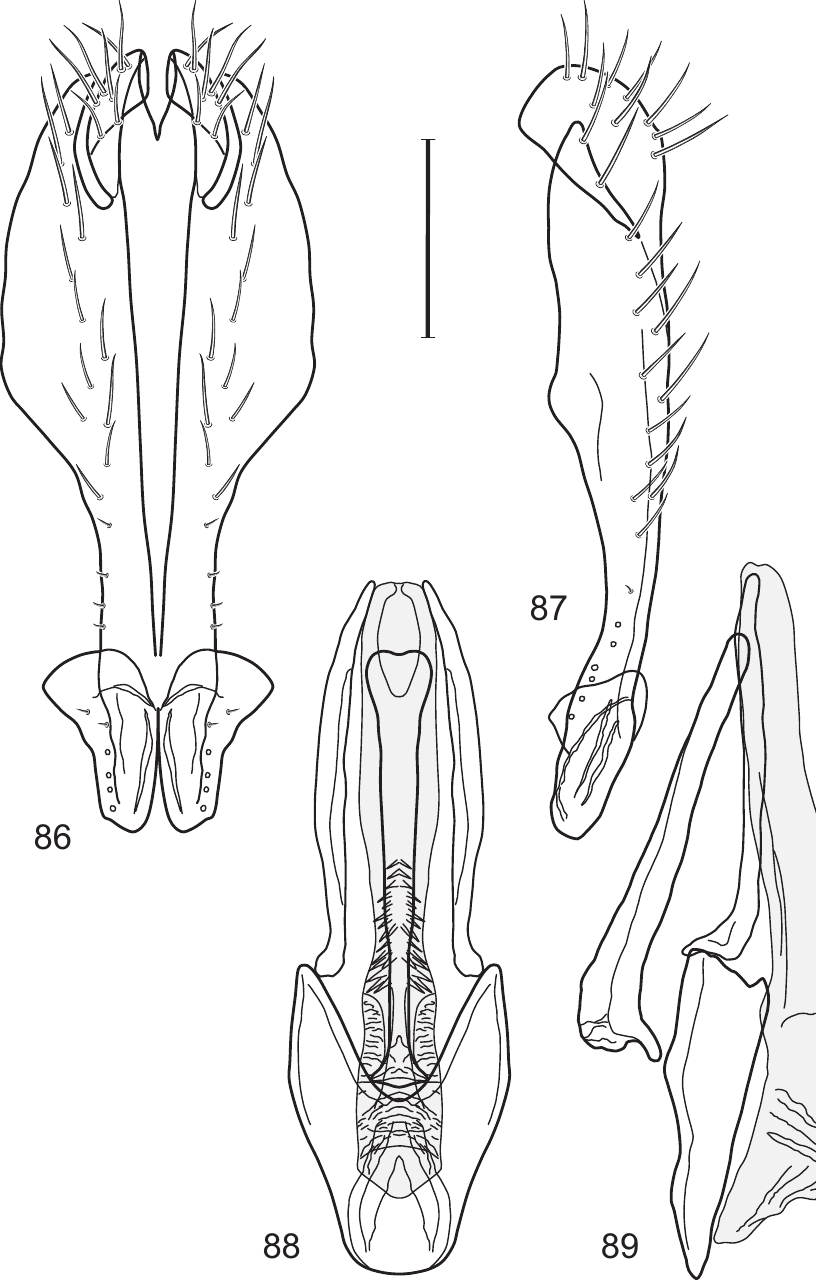
Figures 86–89. Hydrochasma glochium sp. n. (Dominican Republic. Puerto Plata (14 km W), Rio Camu) 86 epandrium and cerci, posterior view 87 same, lateral view 88 internal structures of male terminalia (aedeagus [shaded], phallapodeme, gonite, hypandrium), ventral view 89 same, lateral view. Scale bar = 0.1